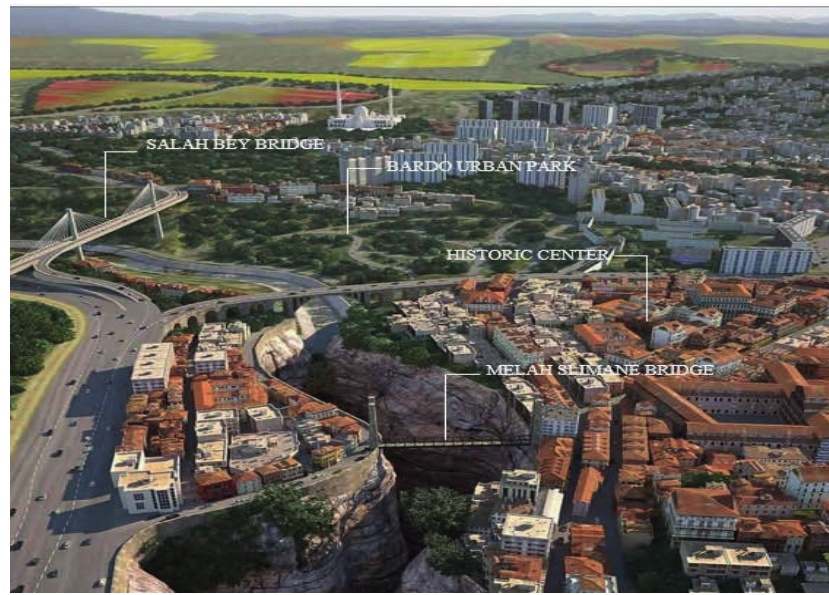
Fig. 5. Situation of the Bardo Park and its insertion in the immediate environment (Google 2021, authors’